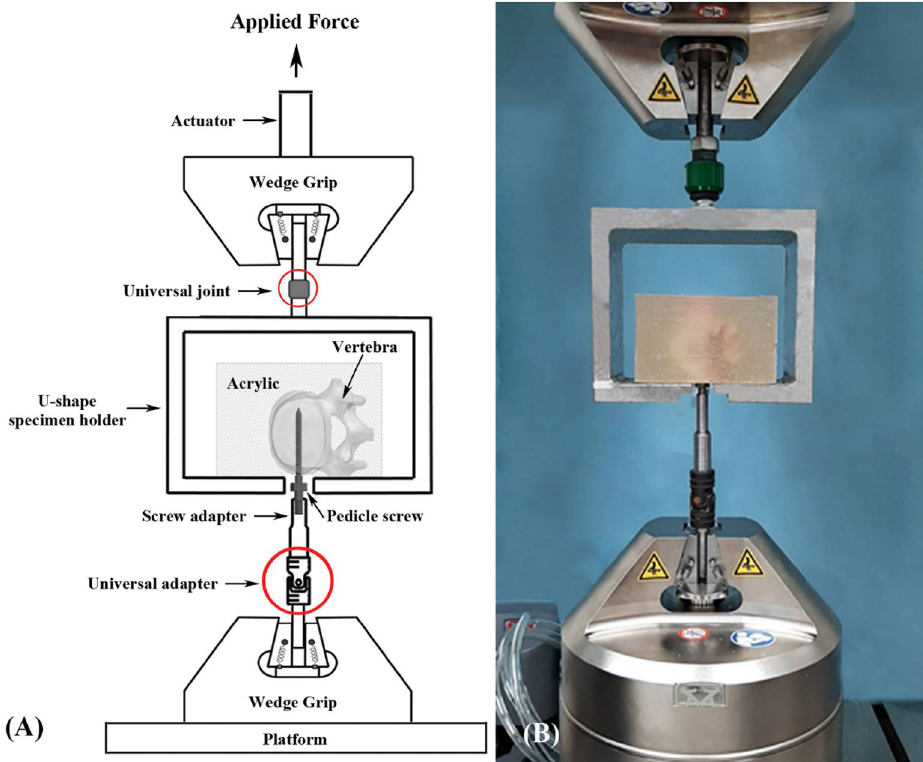
Figure 11. ( A ) Schematic drawing and ( B ) photograph showing the experimental setup of the screw pullout test. Porcine vertebra was potted in specific epoxy resins. The prepared specimens were placed on a